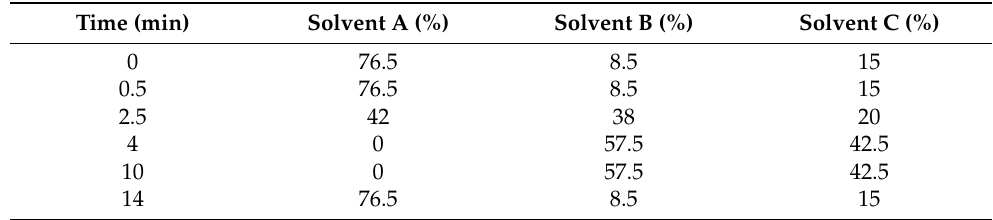
Table 1. HPLC gradient according to Elberskirch et al. [31]. Solvent A: water; solvent B: acetonitrile; solvent C: 0.1% trifluoroacetic acid in